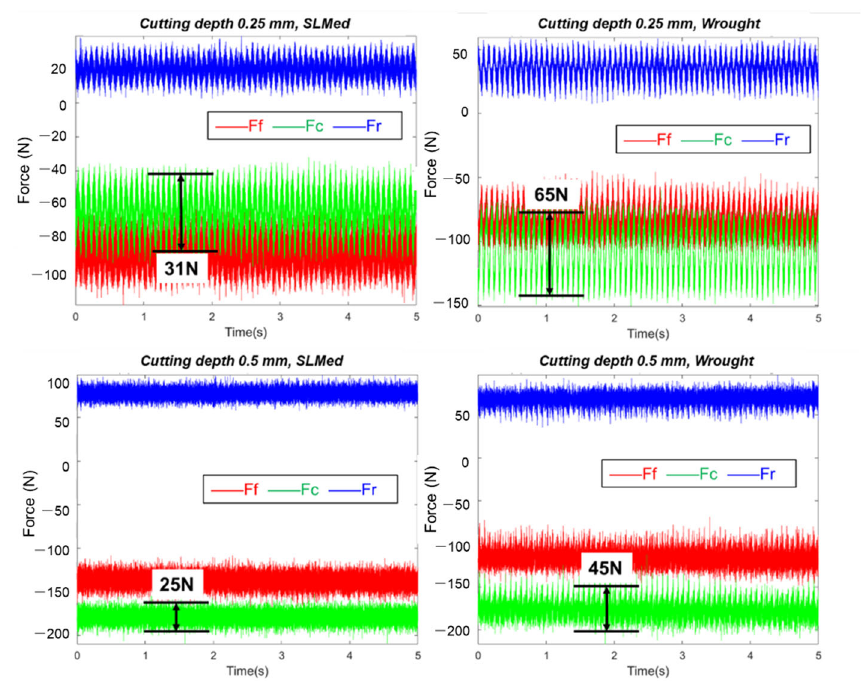
Figure 5. Cutting forces when machining wrought and SLMed Ti6Al4V workpieces at the cutting parameters of 0.2 mm/rev and 120 m/min.